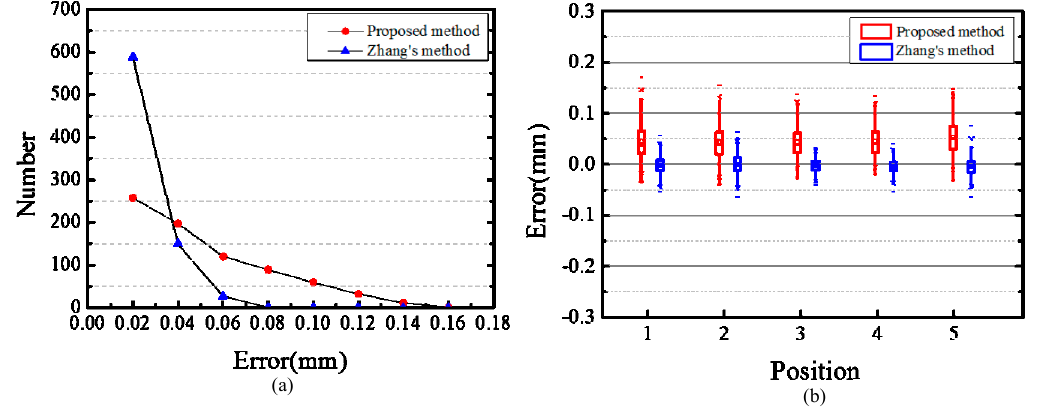
Figure 14. Reconstruction errors of light-emitting planar target via two methods. ( a ) Number of point pairs in different reconstruction error level via two methods; ( b ) Statistical distributions of the reconstruction error of the feature point pairs via two methods.